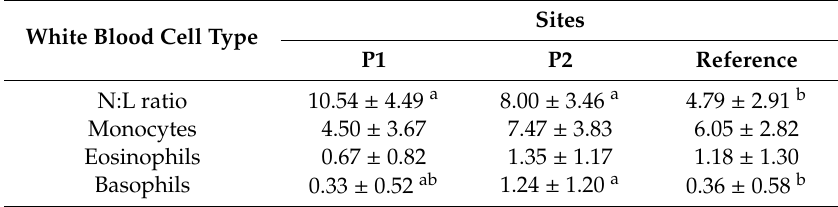
Table 2. Mean values and standard deviation of white blood cell parameters (% (cid:24) ) determined in the Catalan chub from polluted (P1, n = 6; P2, n = 17) and reference (n = 22) sites in Bes ò s River. Di ff erent letters indicate significant di ff erences among sites ( p < 0.05).